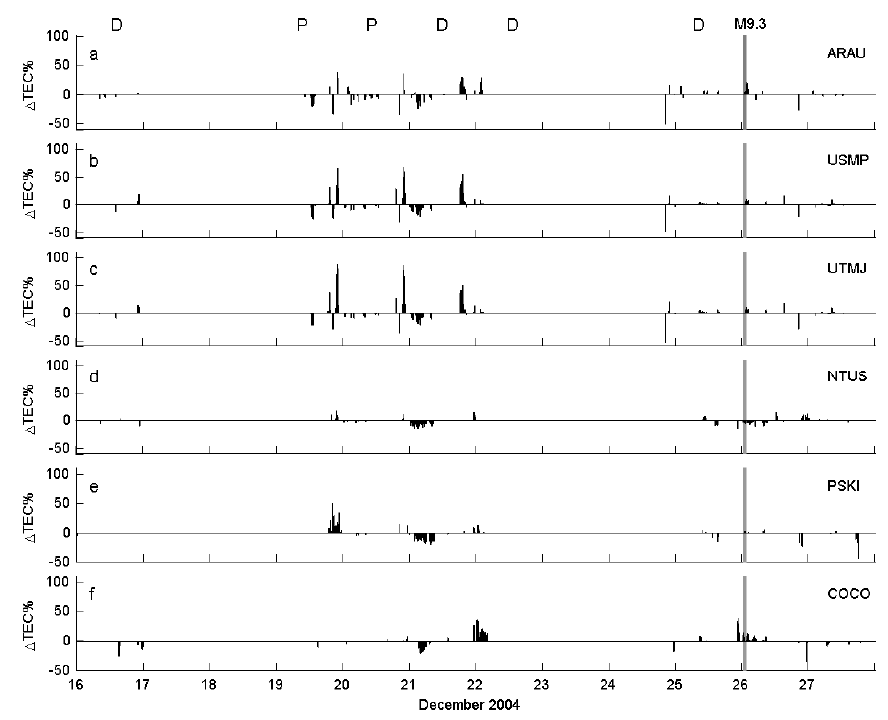
Fig. 3. The percentage of TEC deviation between 19 and 27 December 2004 at 6 GPS stations. The positive and negative values show the filtered TEC% variations with respect to their upper and lower bound, respectively.